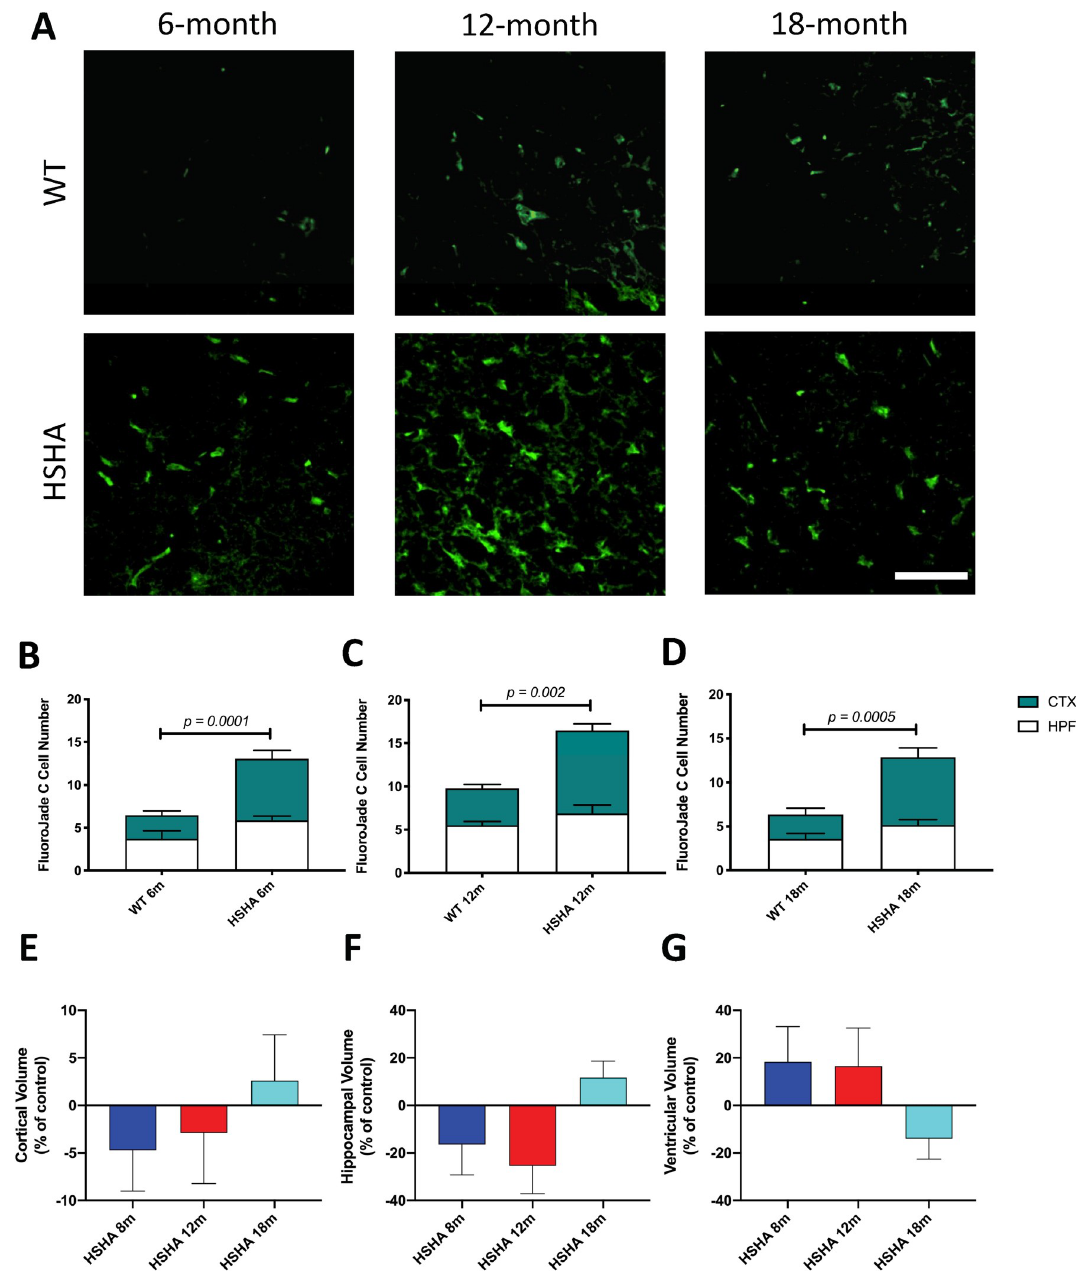
Fig 4. Neuronal degeneration and brain volumetric analyses in HSHA mice. (A) Representative 3D confocal immunomicroscopy images of degenerated neurons in HSHA mice and their respective controls at 6, 12, and 18 months of age, indicated by FluoroJade C staining in green; scale bar depicts 50 μ m (B–D) Quantitative analysis of neuronal degeneration in HSHA mice. The number of degenerative neurons, as indicated by FluoroJade C positive cells assessed by quantitative confocal immunomicroscopy, is shown in 6-month-old (B ), 12-month-old (C), and 18-month-old (D) HSHA mice and their respective age-matched controls, in the CTX and HPF. Statistical significance was tested by an unpaired t test with Welch AU : PleasenotethatasperPLOSstyle ; eponymictermsshouldnotbepossessive : Hence ; allinstancesofWelchscorrectiontestinghavebeenreplacedwithWelchcorrectiontestingthroughoutthetext : Pleasecheckandcorrectifnecessary : correction testing for nonequivalence of standard deviations. Data are presented as mean ± SEM ( n = 4–10; p -values only indicated for significance). (E–G) Comparison of regional brain volumes measured by in vivo 3D T2-weighted MRI in young and old HSHA mice. The percentage volume difference between (E) CTX, (F) HPF, and (G) combined lateral, third, fourth, and cerebral aqueduct VNT volumes versus the respective regional mean volume of HSHA mice and their WT controls at 8, 12, and 18 months, are indicated. Each image data set was reconstructed, processed, coregistered with the Allen Mouse Brain Atlas, and analysed per region of interest ( n = 2–3). Treatment differences were assessed by one-way ANOVA by comparing the percentage volume difference for HPF, CTX, and VNT size versus the respective regional mean volumes at 8, 12, and 18 months of age. No significant differences were observed at p < 0.05. The data underlying